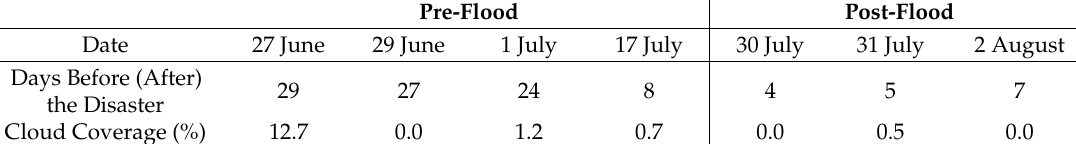
Table 10. The dates and cloud coverages of pre- and post-flood DNB images of the Yulin Flood.